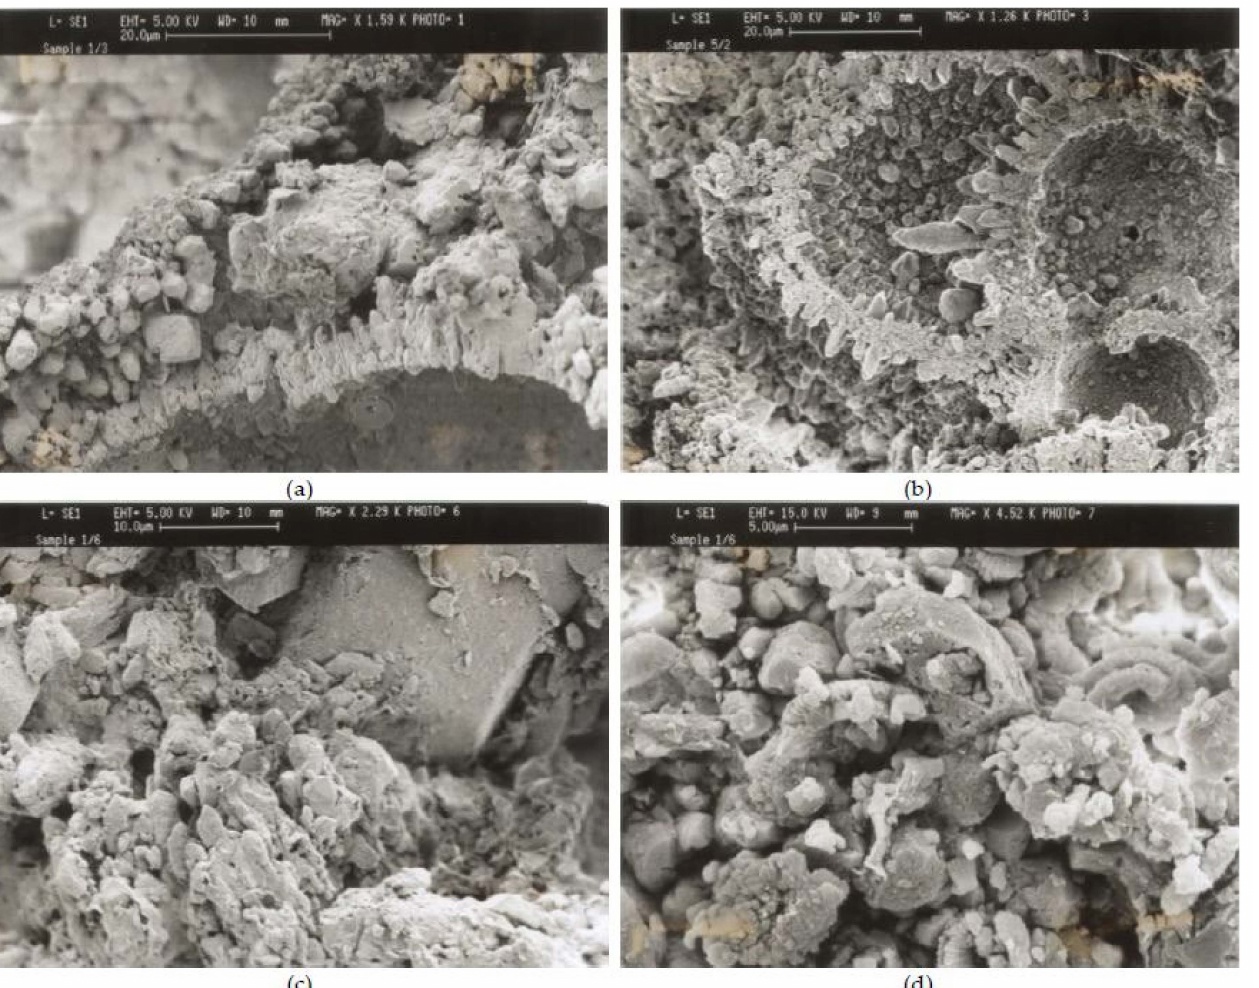
Figure 12. SEM images illustrating the pore structure, the physico-mechanical interlocking and the fine-grained sparry calcite cement of samples from: ( a ) the first-quality bed within Tal-Warda quarry; ( b ) the Church of Santa Maria, Birkirkara; ( c ) the second-quality bed within Tal-Warda quarry; ( d ) micrite matrix in the second-quality bed within Tal-Warda